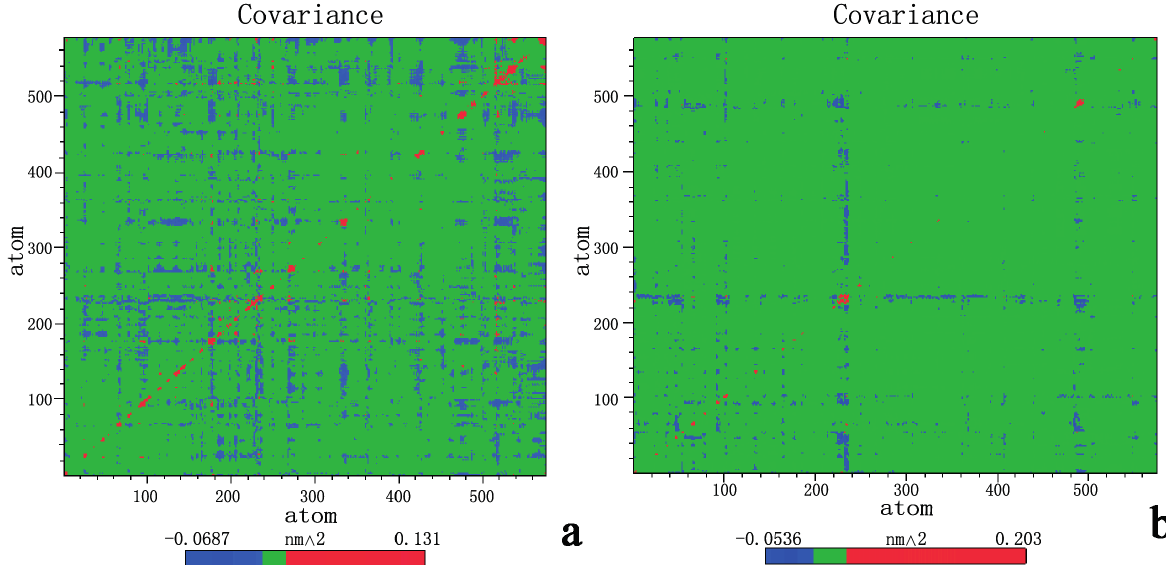
Figure 9. Cross-correlation matrix of the fluctuations of each of the x , y , and z coordinates of the C α atoms from their average during 100 ns MD ( a ) chlorpyrifosmethyl oxon; and ( b ) dichlorvos. Blue color represents the negative anticorrelation, green represents noncorrelated, random motions, and red represents positive correlation. The two figures were made using Adobe Illustrator